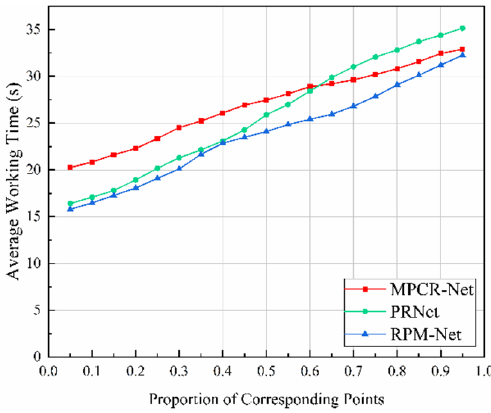
Figure 12. Average time of MPCR-Net, PRNet, and RPM-Net under different proportions of